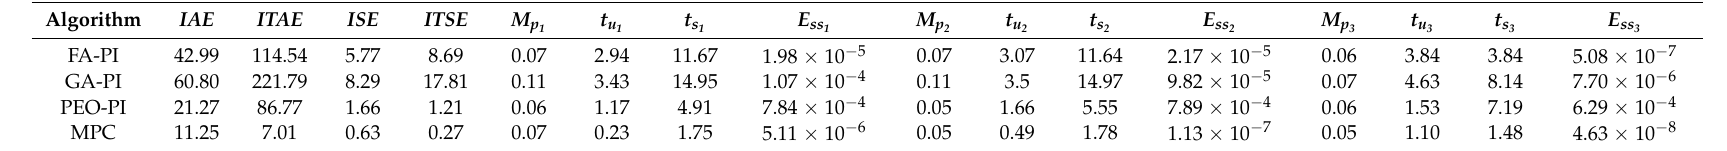
Table 5. Performance comparison of MPC, PEO-PI, GA-PI and FA-PI for case